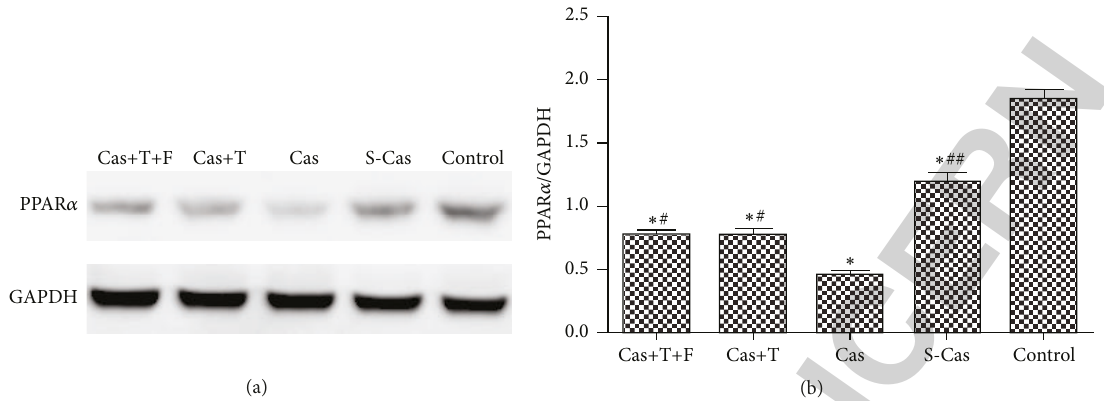
Figure 2: Effects of castration and testosterone replacement on the protein expression of PPAR 𝛼 in heart. (a) Western blotting result for PPAR 𝛼 protein level. (b) Quantitation of PPAR 𝛼 protein level. Values are means ± SD; 𝑛 = 3 . S-Cas: sham-castration; Cas: castration; T: testosterone; F: flutamide. ∗ 𝑃 < 0.001 versus control group; # 𝑃 < 0.01 and ## 𝑃 < 0.001 versus Cas.